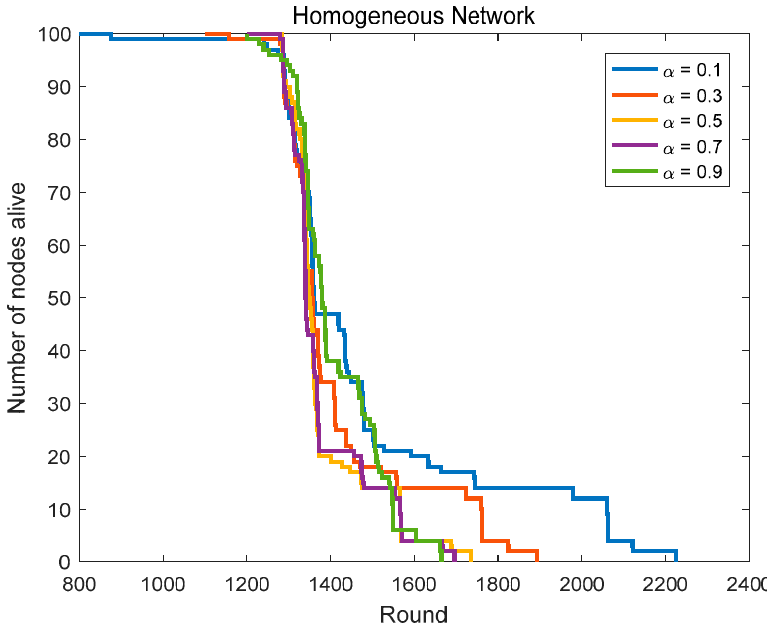
Figure 9. The network lifetime comparison in homogeneous networks (routing factor = 0.1, 0.3, 0.5, 0.7 and 0.9).